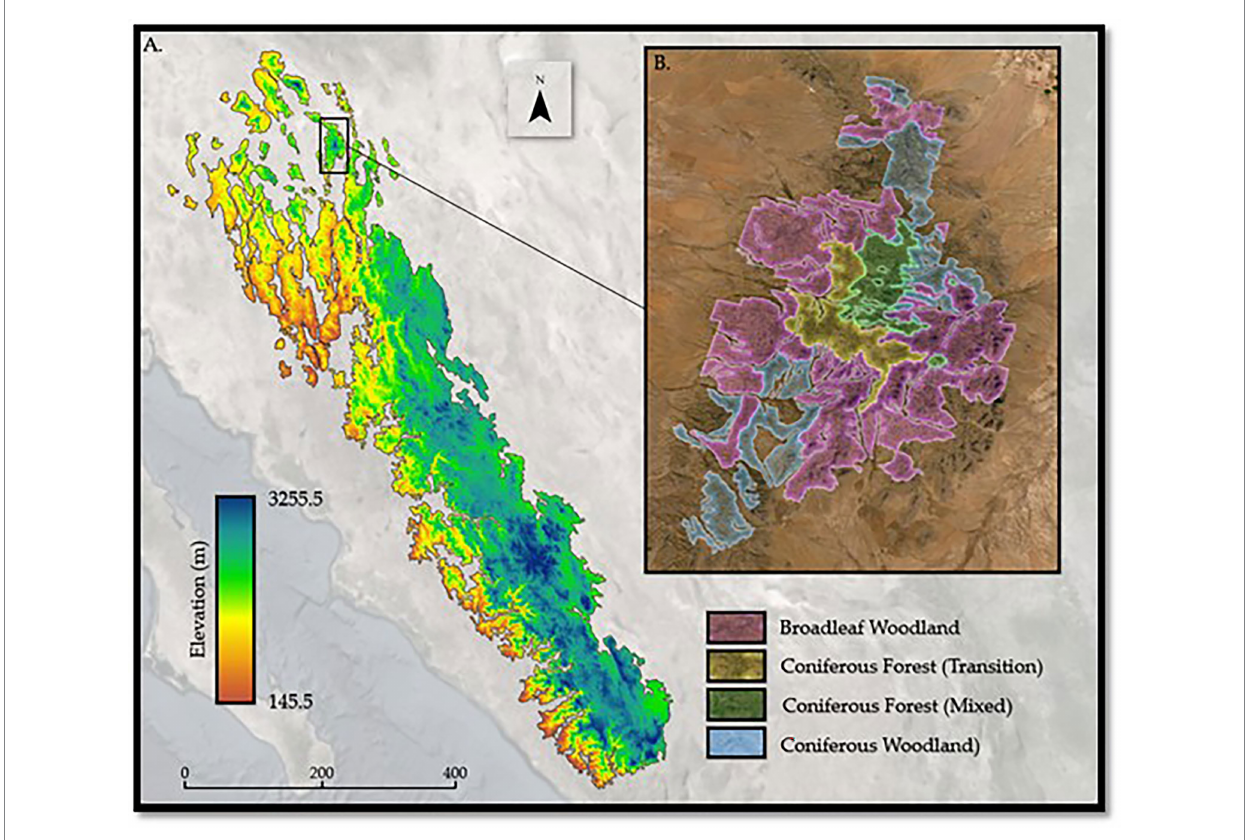
FIGURE 2 (A) Elevation gradient for the spatial extent of the Sierra Madre Occidental and, (B) Expert-defined spatial extents of the four forest communities of